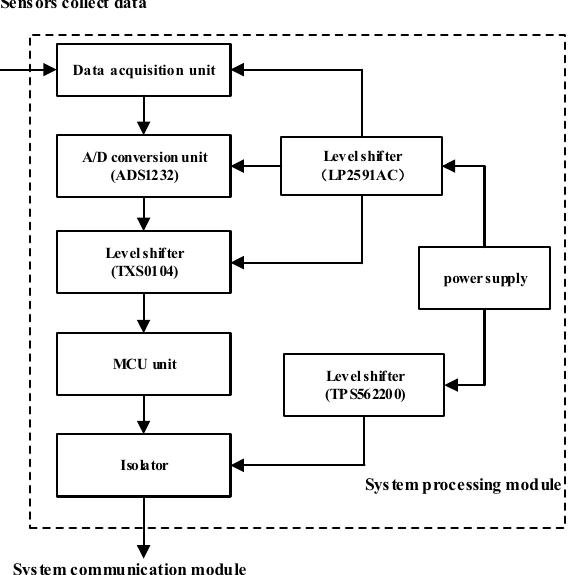
Figure 3. Working principle diagram of data processing